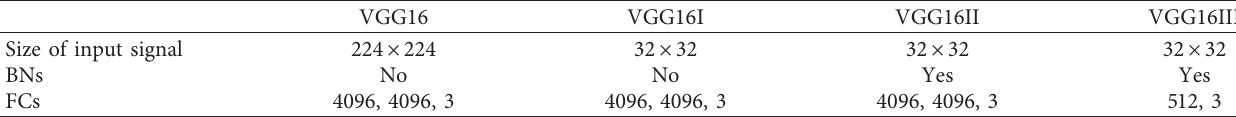
Table 6: VGG16 and three kinds of variants.